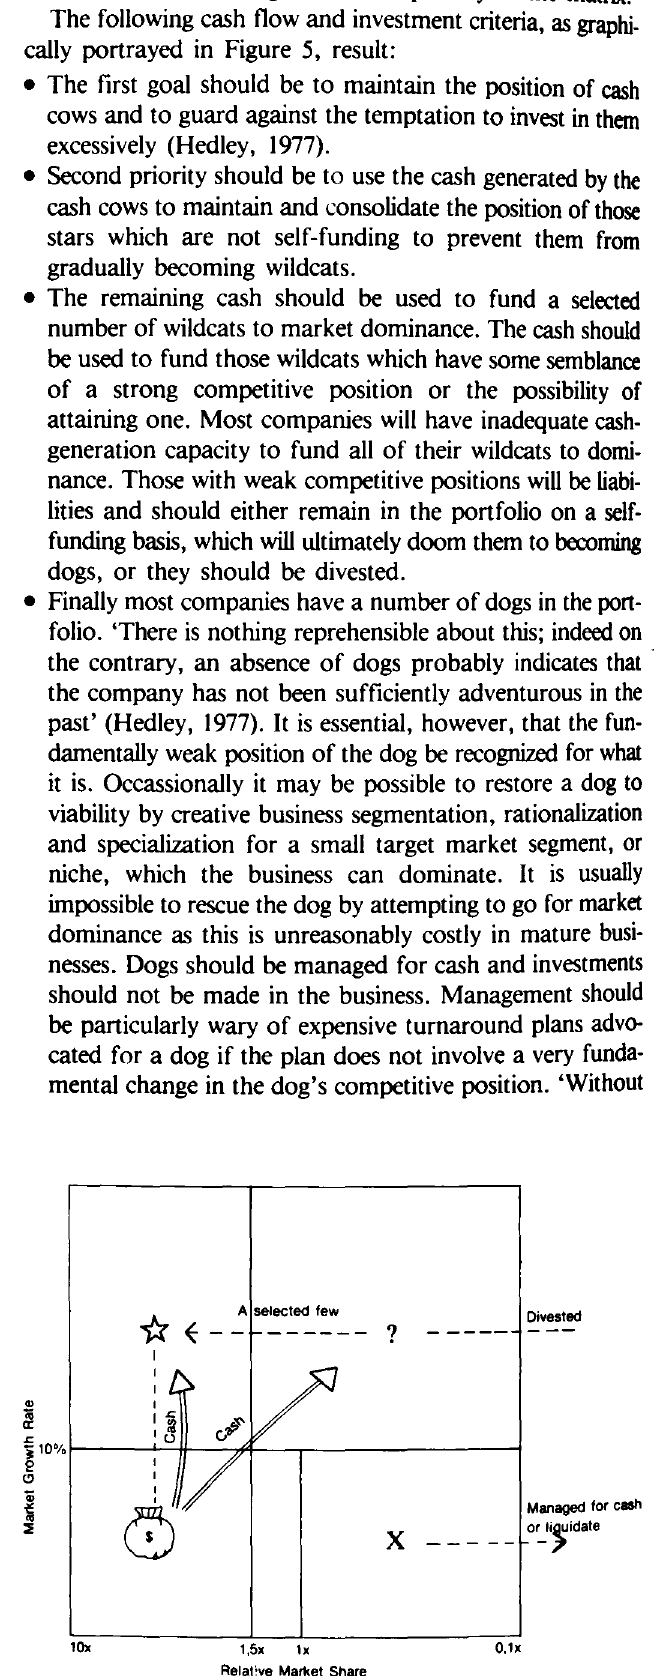
Figure S Strategic progress, cash flow and investment criteria on the growth share